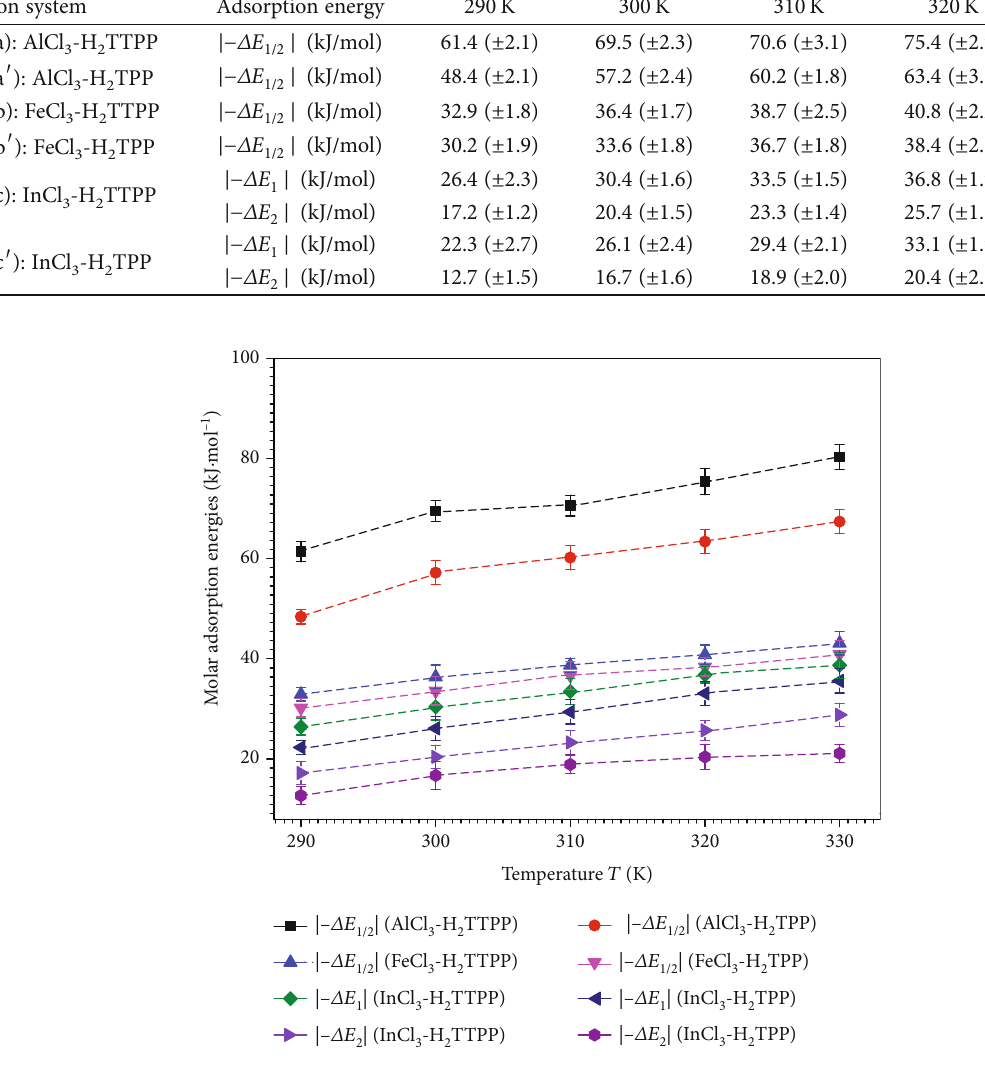
Figure 8: Evolutions of the molar adsorption energies of the six adsorption systems as a function of temperature: ∣− Δ E FeCl , and ∣− Δ E 1 ∣ and ∣− Δ E 2 ∣ for InCl 3